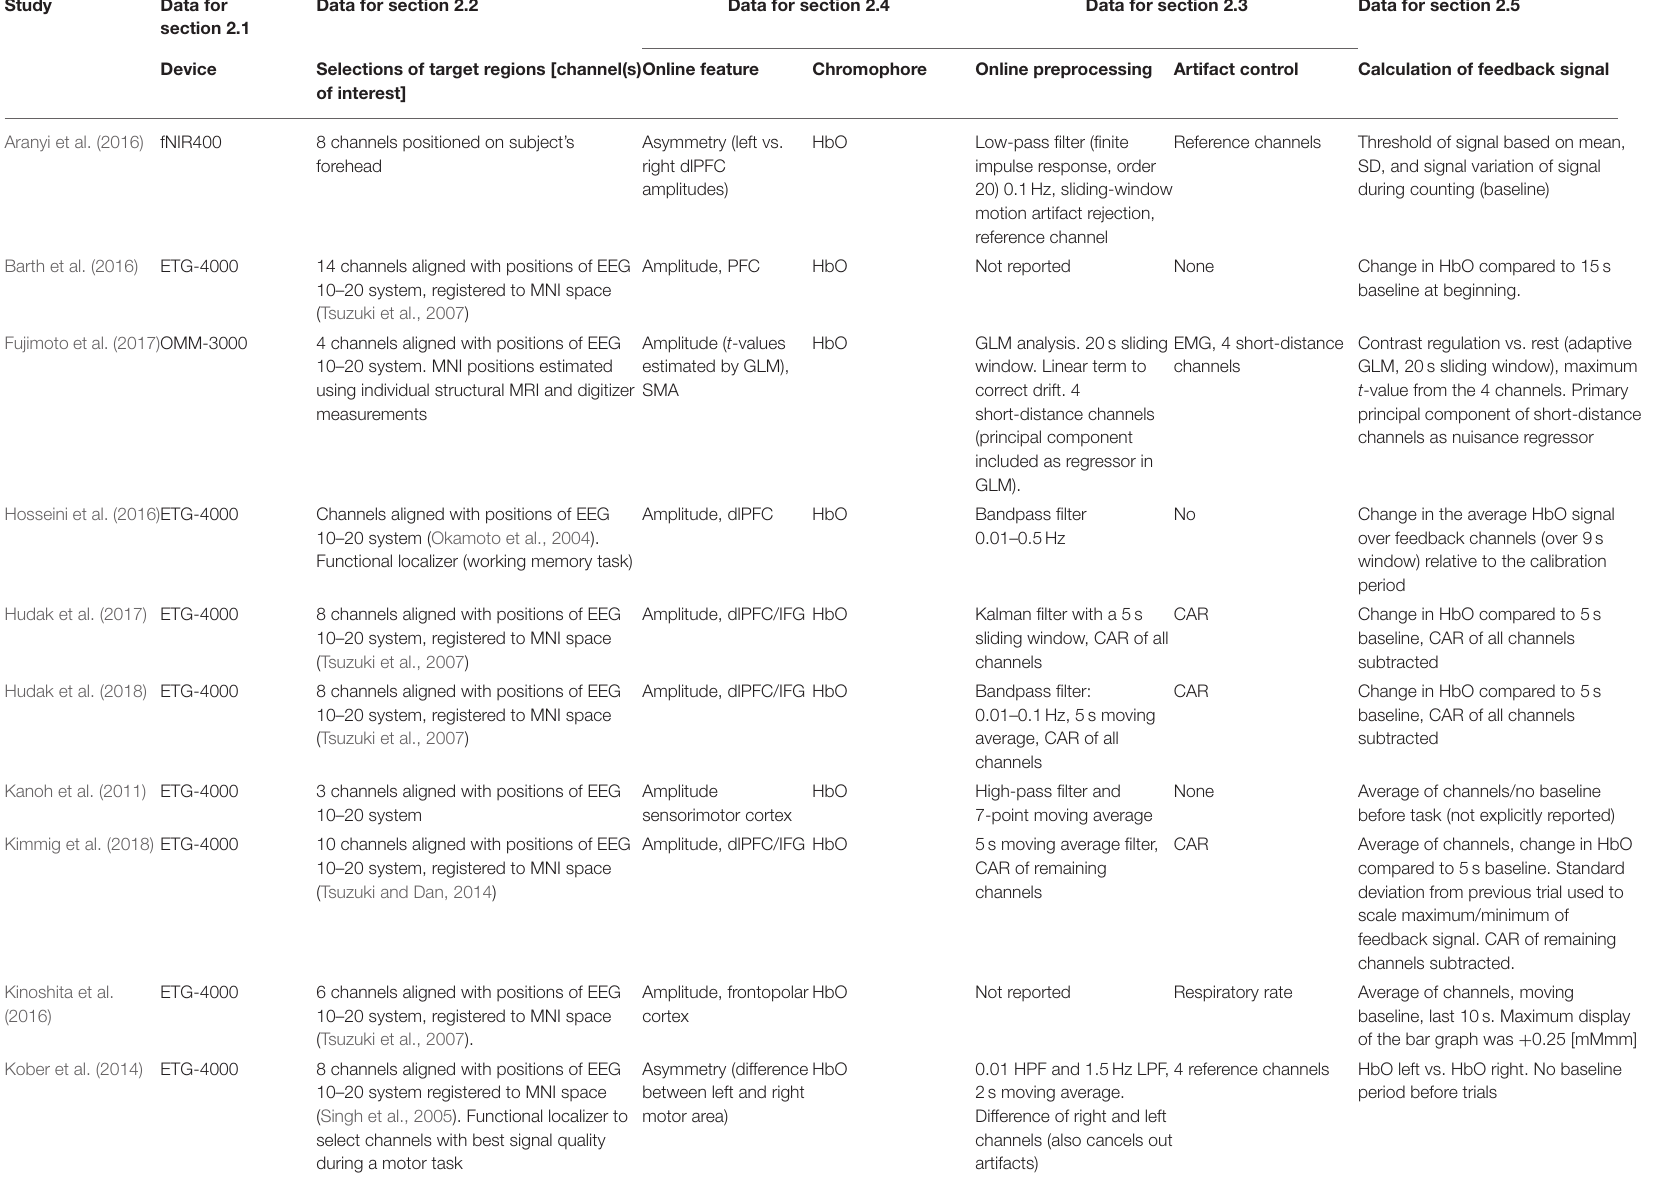
TABLE 2 | Online signal-processing methods and